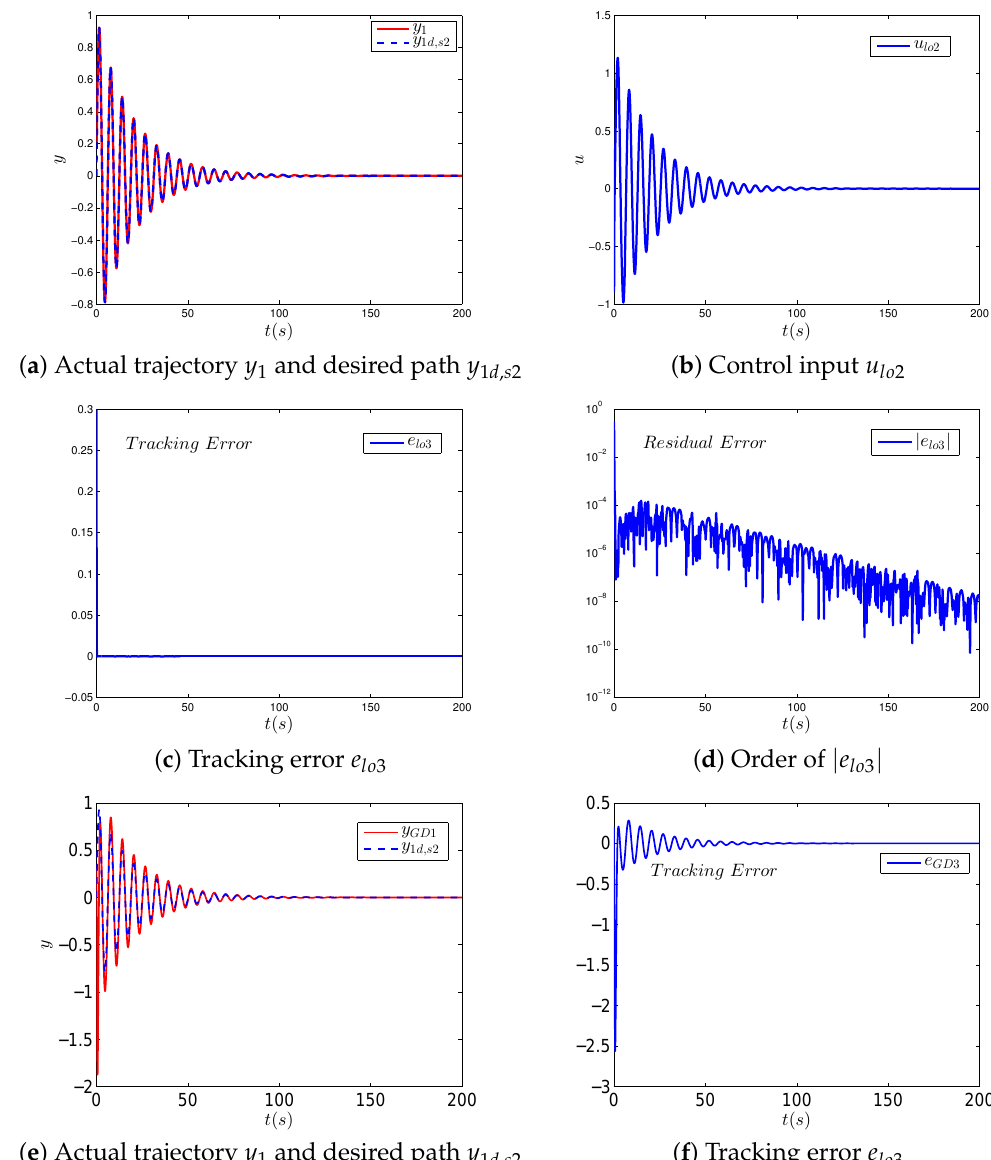
Figure 6. Tracking performance of ZD and GD controllers to solve the tracking control problem with single linear output of the single-link manipulator with flexible joints for the desired path y 1 d , s 2 = sin ( t ) exp ( − t /20 )